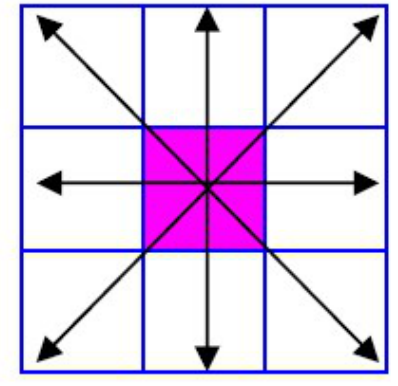
Figure 1. The discretization of the gradient